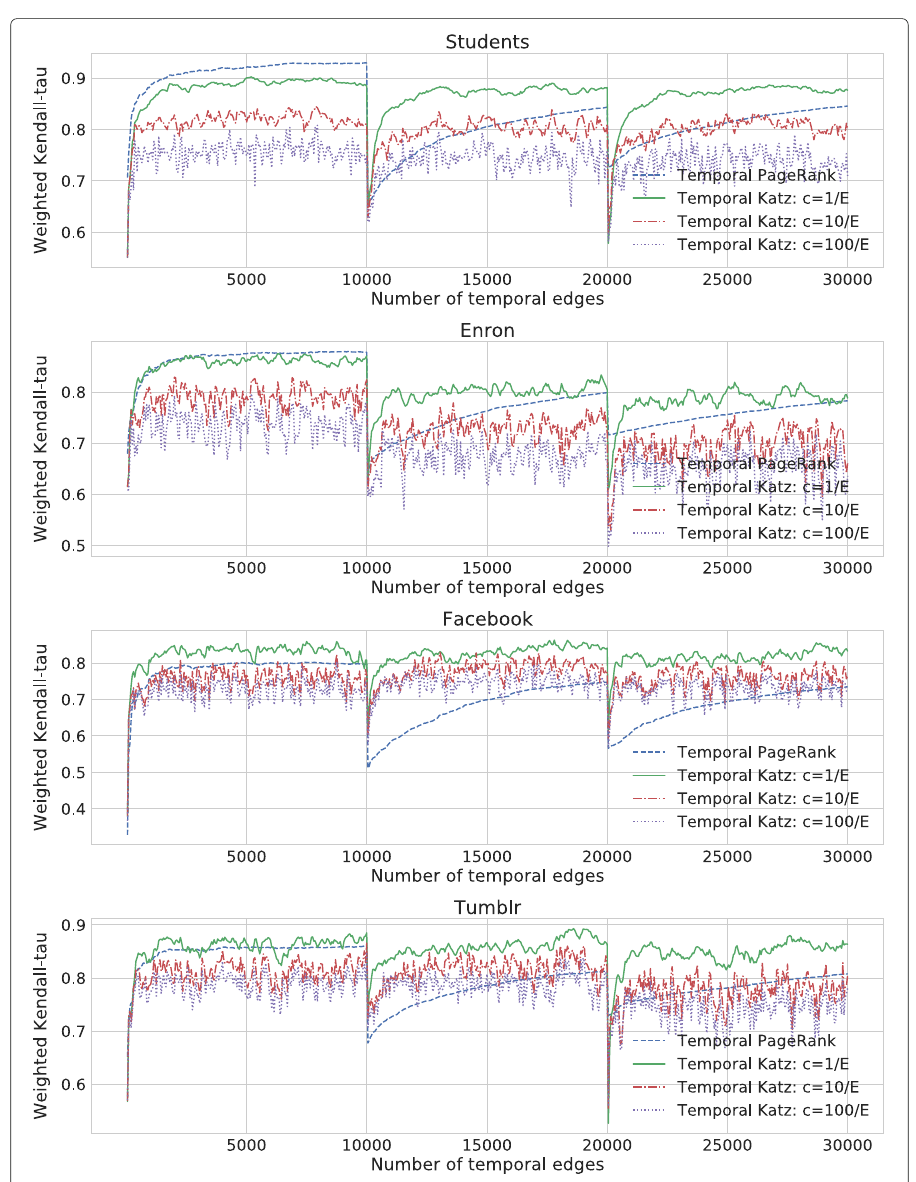
Fig. 9 Weighted Kendall tau rank distance of static Katz index and online methods by sampling to simulate concept drift over Students, Enron, Facebook and Tumblr data. Static Katz index has β = 0.01. The Weighted Kendall tau curves for temporal Katz centrality with c = 1 | purple, and for temporal PageRank are blue dashed. Noise in temporal Katz centrality is due to the effect of the most recently selected edges. The two vertical bars mark the time of the concept drift, when a new sampling distribution is used to generate the temporal